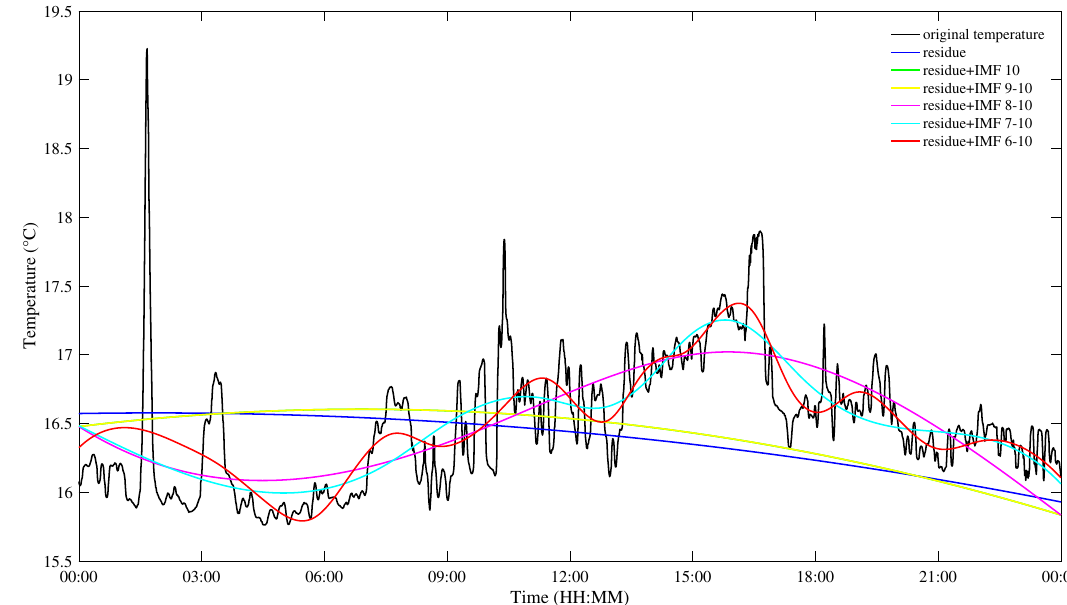
Figure 10. Superposition of different IMFs and residue of EEMD of temperature at a depth of 155 m on July 29, 2018.